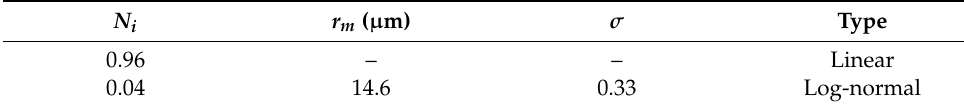
The choices of N i in Table 3 are normalized to correspond to 1 particle/m 3 ,